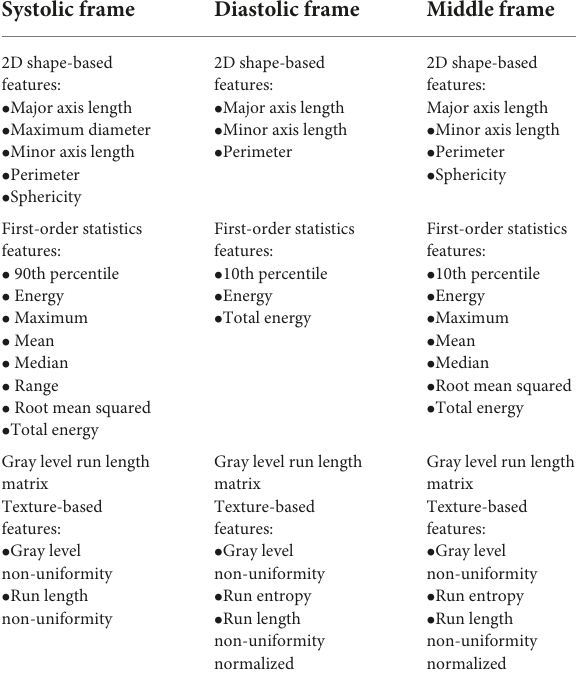
TABLE 4 Statistically significant radiomics features of the three cine short-axis image frames. Systolic frame Diastolic frame Middle